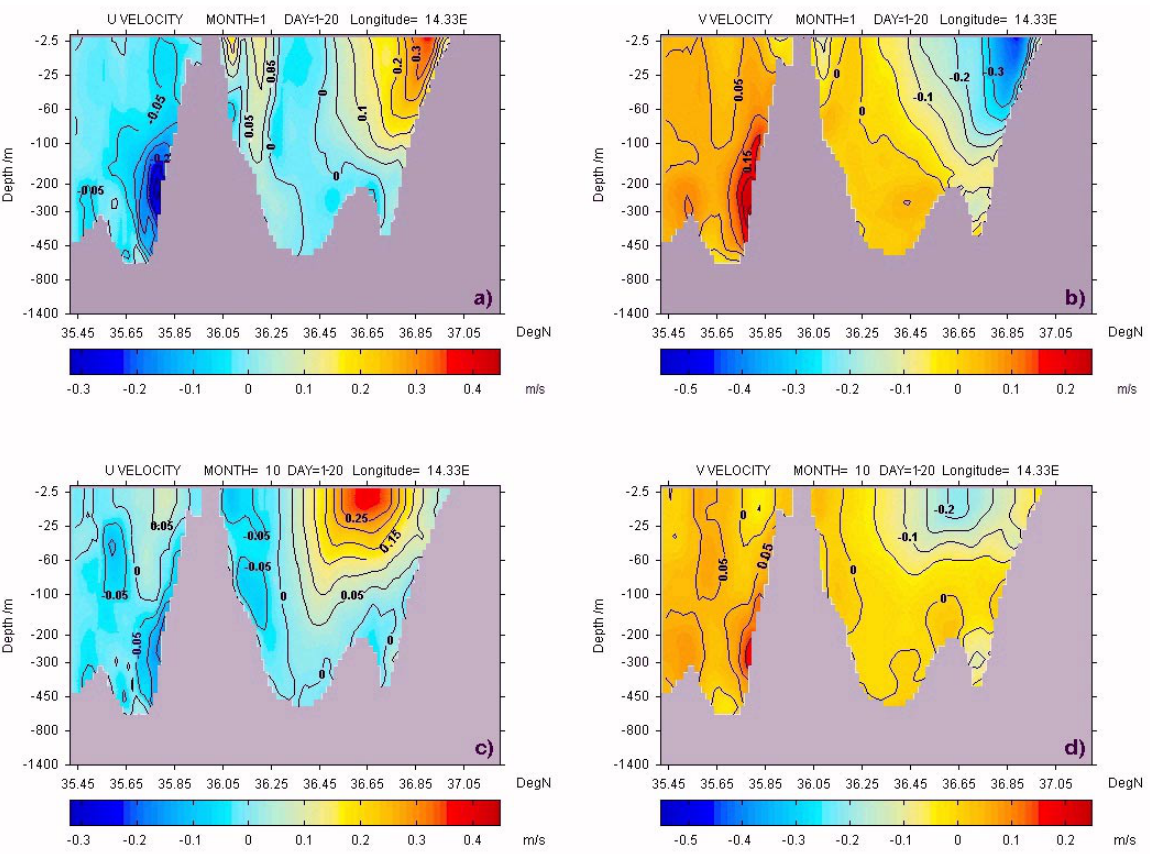
Fig. 13. Vertical sections of 10-day averaged east-west total velocity components and north-south total velocity components for the second third of January (a) and (b) , and for the second third of October (c) and (d) . The section runs from south to north along longitude 14 ◦ 20 0 E. In (a) and (c) positive velocities are directed towards east and negative velocities directed towards west. In (b) and (d) positive velocities are directed towards north and negative velocities directed towards